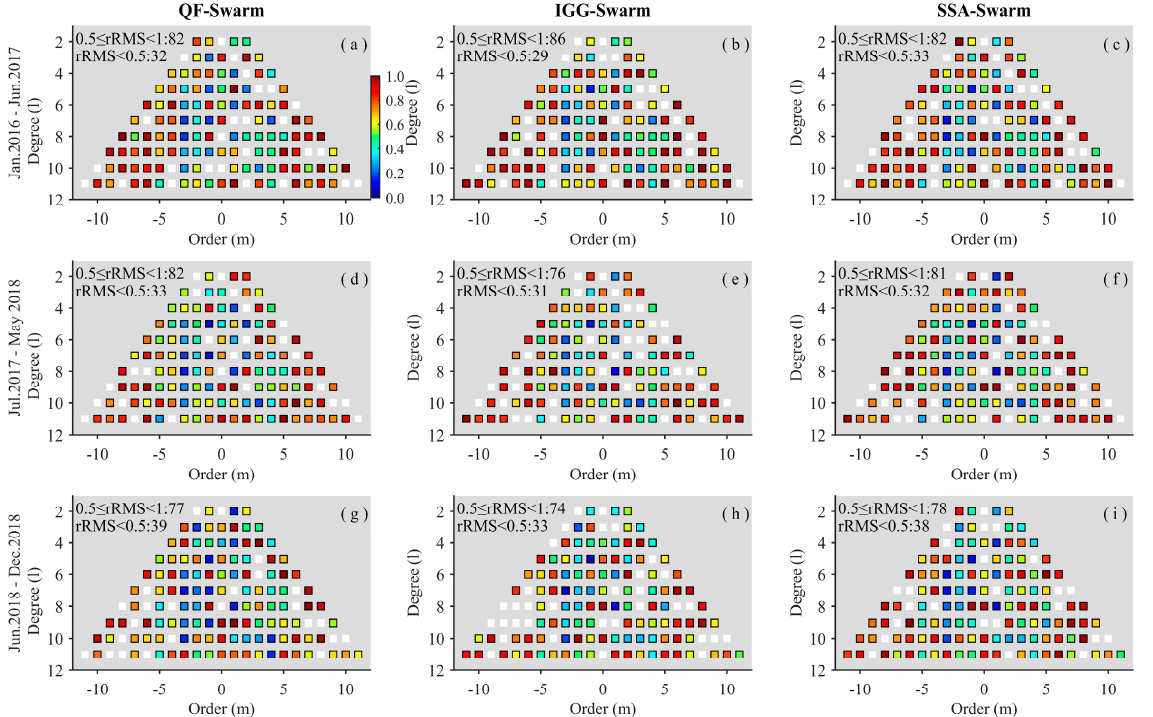
Figure 1. rRMS values of the SHCs on the d/o plane (2 ≤ l ≤ 11) between the three datasets and Swarm datasets over three time periods: ( a – c ) End of GRACE (January 2016–June 2017), ( d – f ) the 11-month gap (July 2017–May 2018), and ( g – i ) beginning of GFO (June 2018–December 2018).